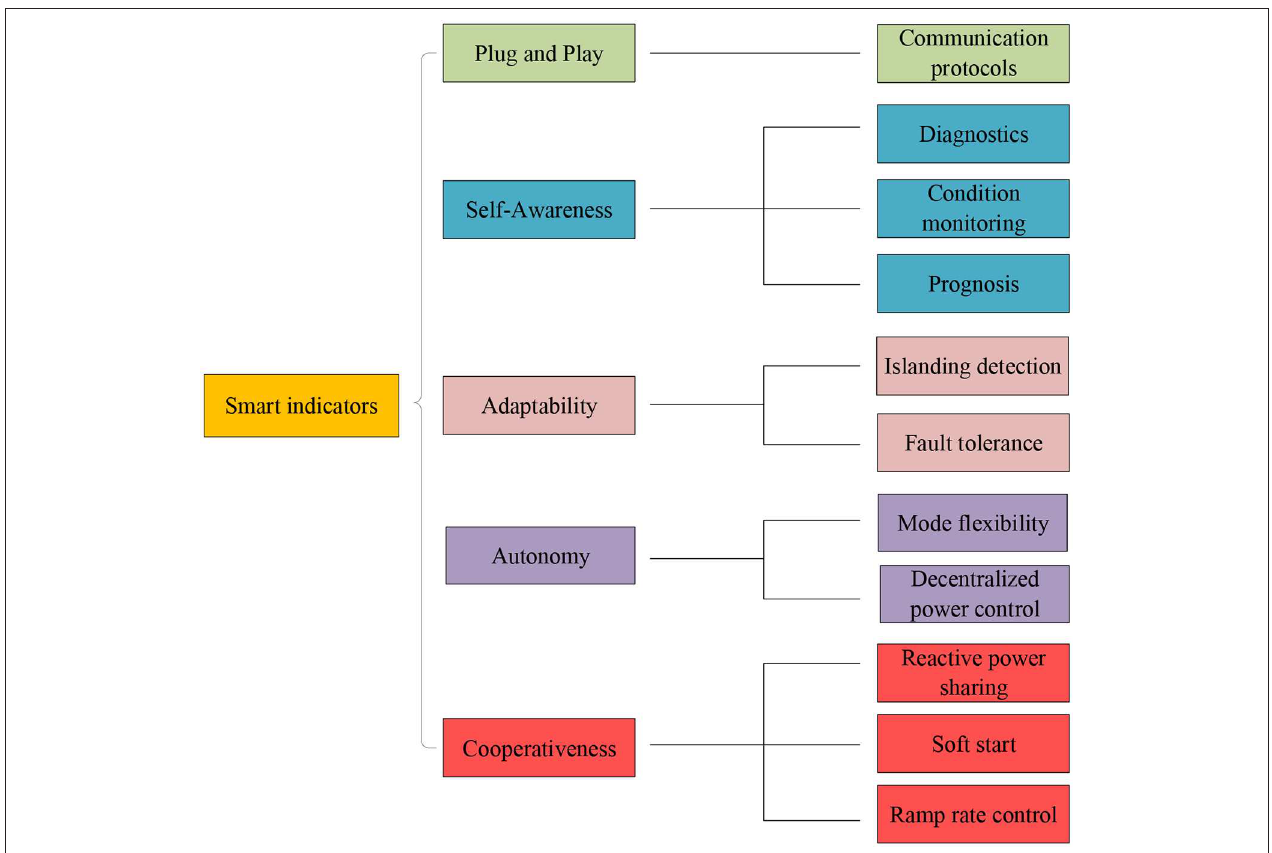
FIGURE 1 | Smart indicators of smart